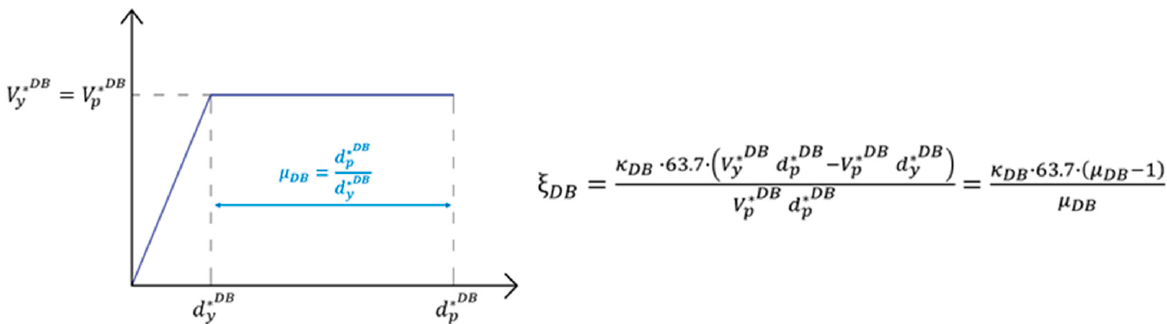
Figure 7. Force-displacement of the equivalent SDOF damped brace. 𝑉 (cid:3052)∗(cid:3005)(cid:3003) and 𝑉 (cid:3043)∗(cid:3005)(cid:3003) : yield and ultimate force; 𝑑 (cid:3052)∗(cid:3005)(cid:3003) and 𝑑 (cid:3043)∗(cid:3005)(cid:3003) : yield and ultimate displacement; 𝜇 (cid:3005)(cid:3003) : ductility factor.